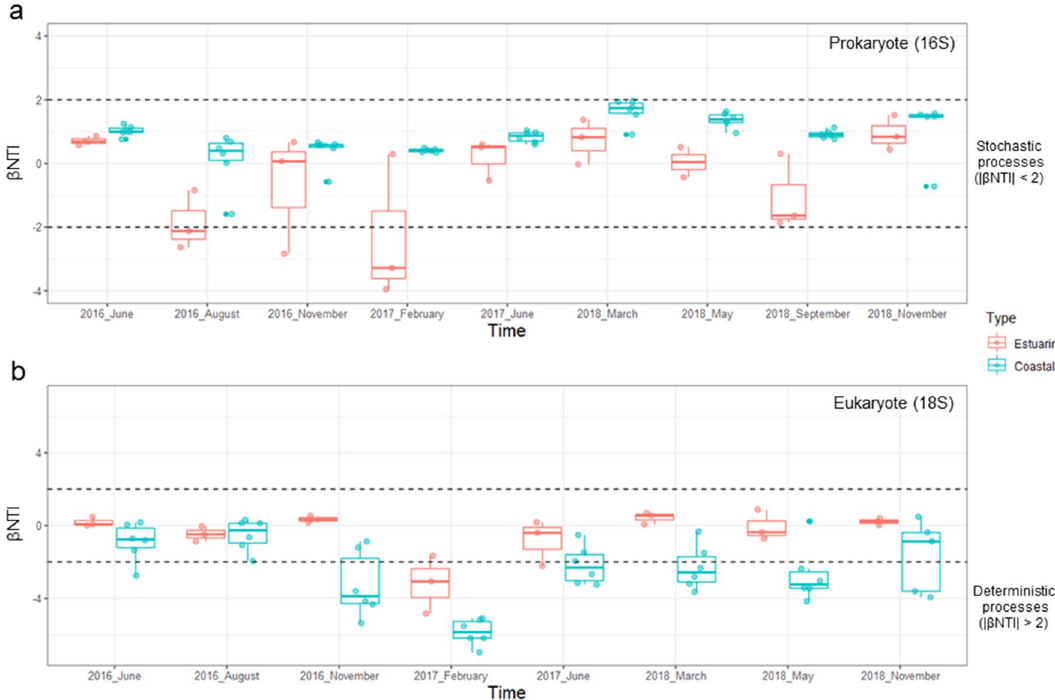
Figure 4. The relative influence of deterministic and stochastic processes in microbial communities using β-Nearest Taxon Index (βNTI). ( a ) Prokaryotic community and ( b ) eukaryotic community. βNTI values determine the relative influence of deterministic (|βNTI|> 2) and stochastic (|βNTI|< 2) processes on community